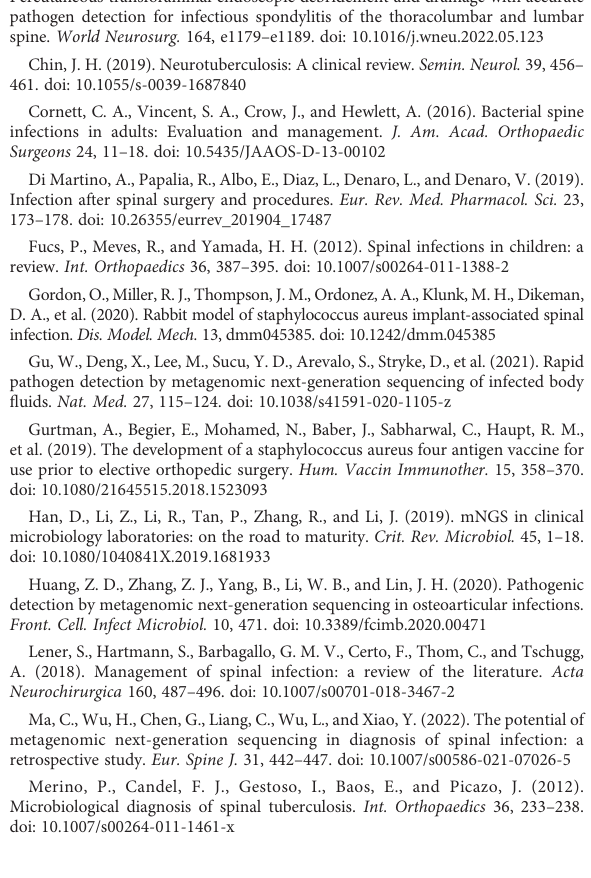
SUPPLEMENTARY FIGURE 2 Image indicates the culture results for